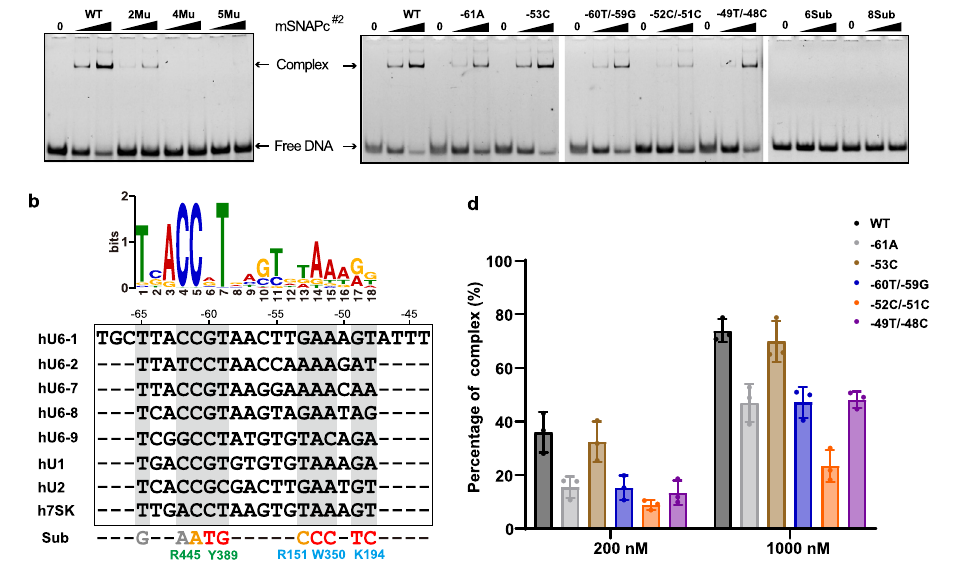
Fig. 4 | PSE-recognition relies on synergistic action of multiple residues of SNAPc. a The binding activities of WT, 2Mu, 4Mu, 5Mu mSNAPc #2 with U6-1 PSE were analyzed by EMSA. For each experiment, 200 and 1000nM proteins (WT or mutant) were mixed with 50nM fl uorescently labeled 25bp DNA probes. This experimentwasrepeated independentlythreetimeswithsimilarresults. b The top panel showed a LOGO pro fi le of human PSE based on sequence alignments of known humanPSEs. The PSE sequences of humanU6-1,U6-2,U6-7, U6-8,U6-9, U1, U2,and7SKareinalignment.ResiduesofSNAPcinvolvedinspeci fi crecognitionof corresponding nucleotides are shown on the bottom. The substituted nucleotides